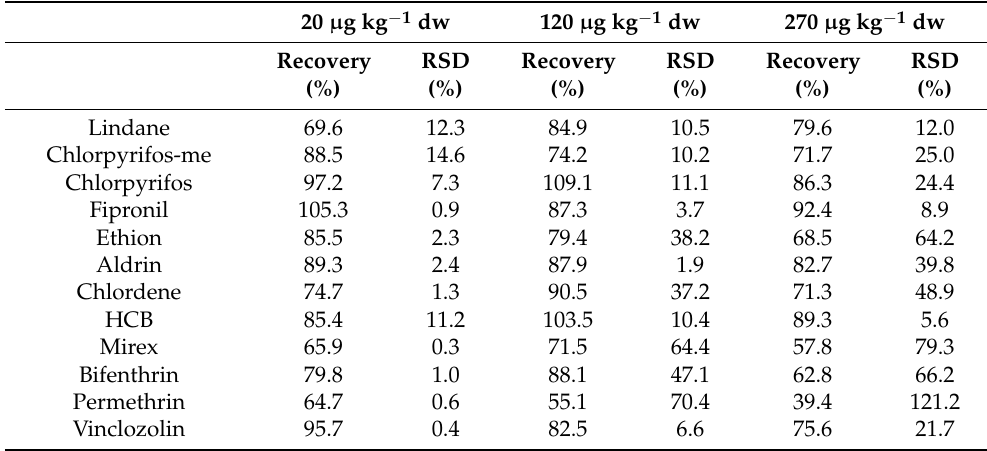
Table 4. Interval (minimum–maximum) of mean extractive recoveries (%) and RSD for the analytes at three concentrations for the fatty fish matrix.